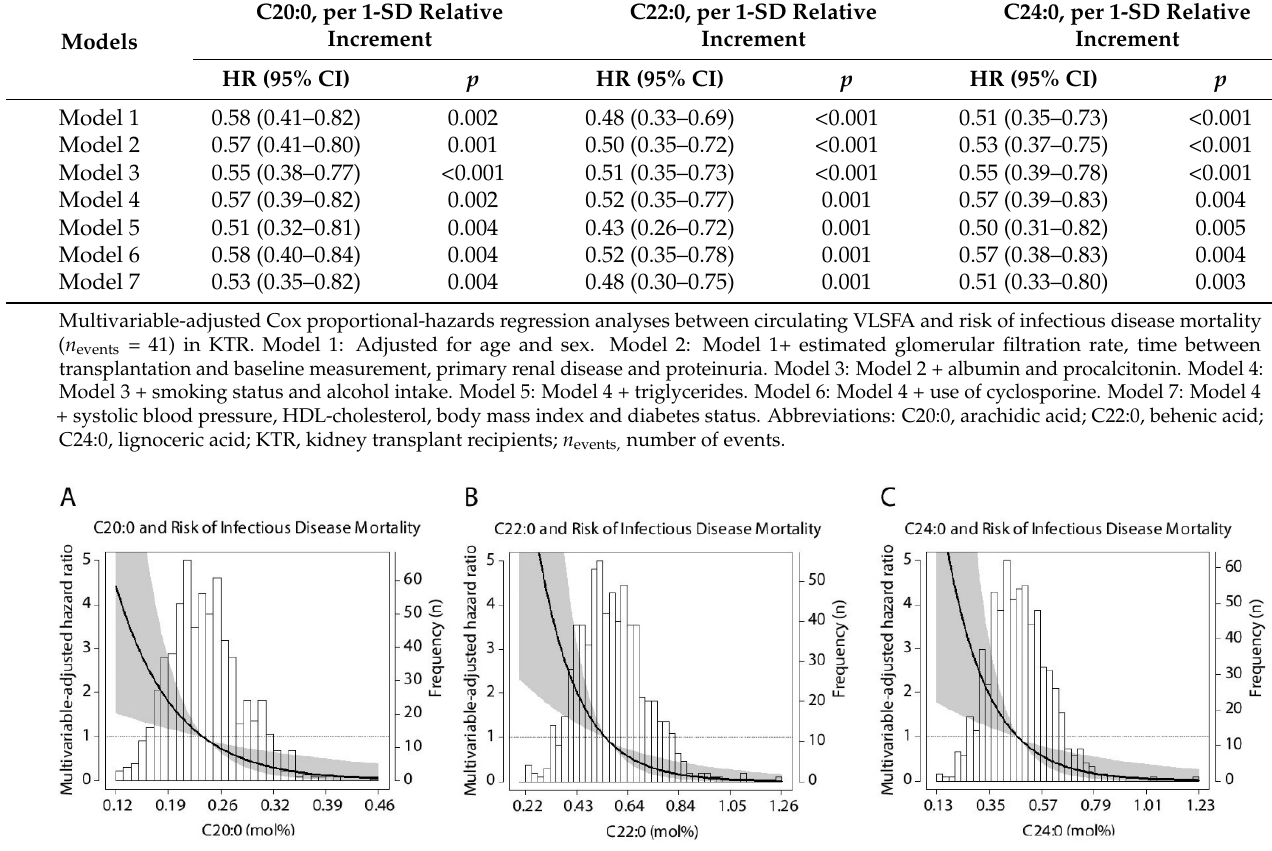
Table 4. Prospective analysis of standardized circulating VLSFA with infectious disease mortality in KTR. Models